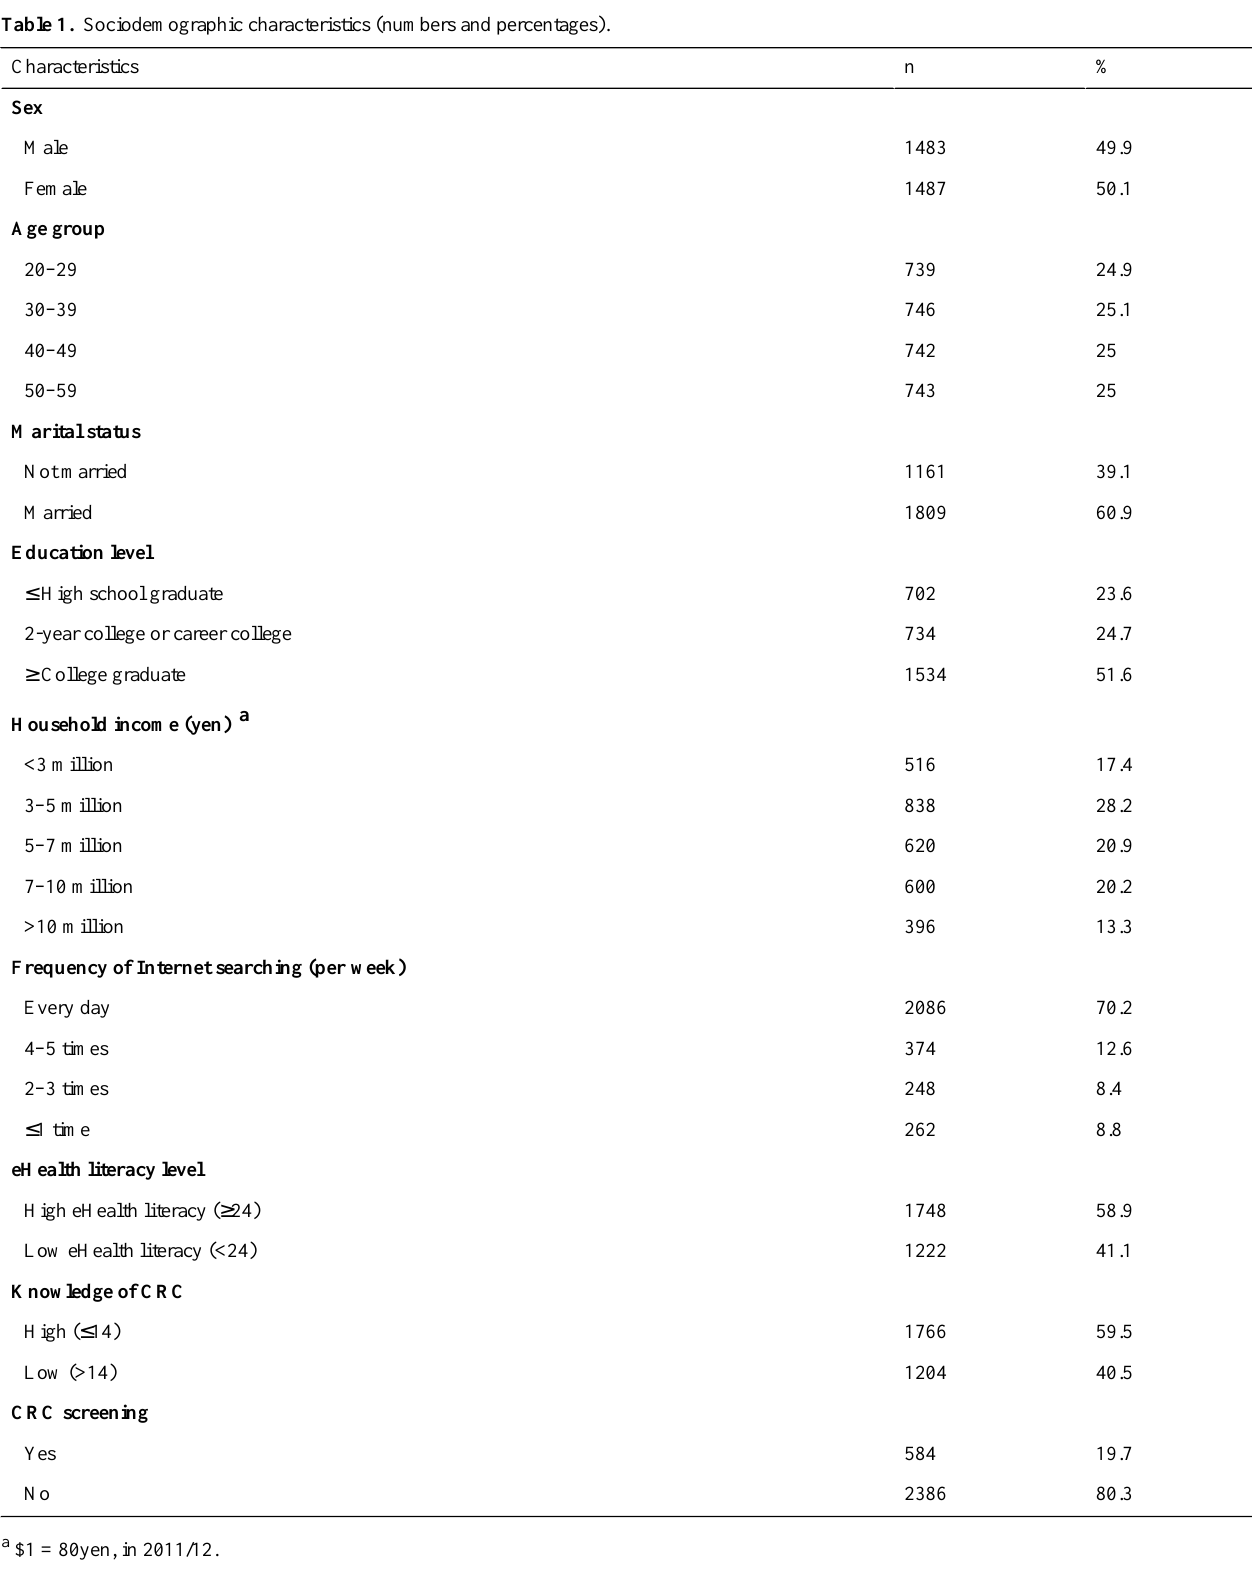
Table 1. Sociodemographic characteristics (numbers and